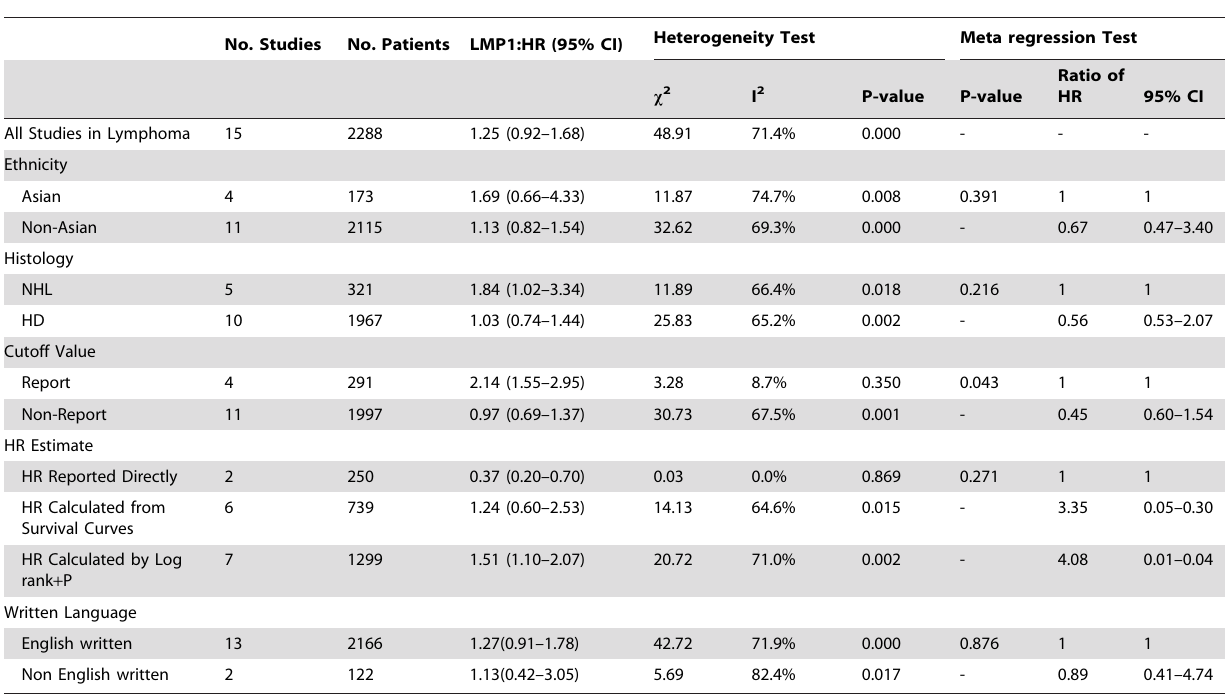
Table 3. The results of summarized HRs in overall and subgroup analyses of survival and the results of meta-regression.